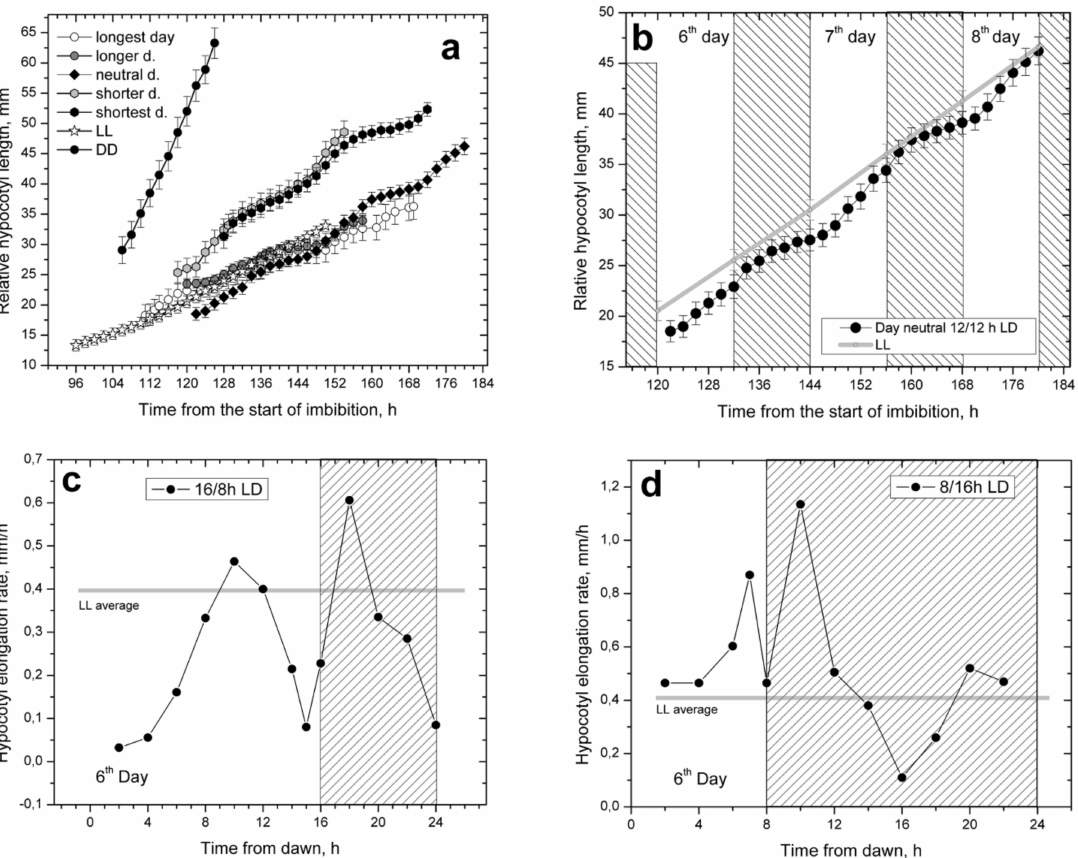
Figure 2. Hypocotyl elongation in diurnal light/dark (LD) photoperiods with light of white LED panels for daytime and true dark for nighttime. ( a ) Five LD photoperiods with rhythmic elongation had similar overall elongation as the free-running constant white light (LL) treatment with uniform hypocotyl elongation. Elongation in the free-running darkness (DD) was much higher than in any of the photoperiods with white light, ( b ) Hypocotyl elongations in day neutral 12/12 h LD photope- riod and LL were highly compatible. Hypocotyl elongation rates in long day 16/8 h LD photoperiod ( c ) and short day 8/16 h LD photoperiod ( d